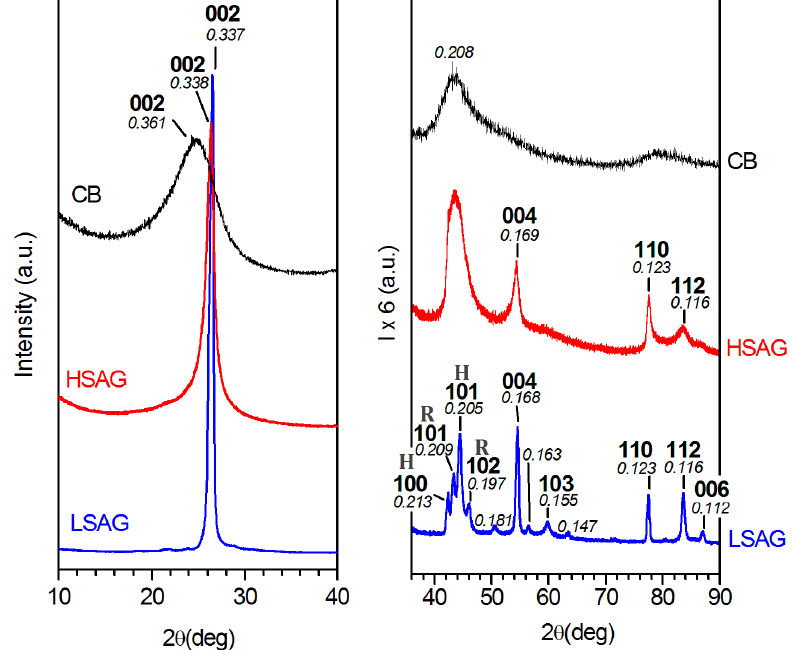
Figure 1. WAXD patterns (Cu K α ), as collected by an automatic powder diffractometer, of used carbon fillers: LSAG (lower blue curve); HSAG (intermediate red curve); CB (upper black curve). H and R labels refer to reflections being specific of hexagonal and rhombohedral phases, respectively.